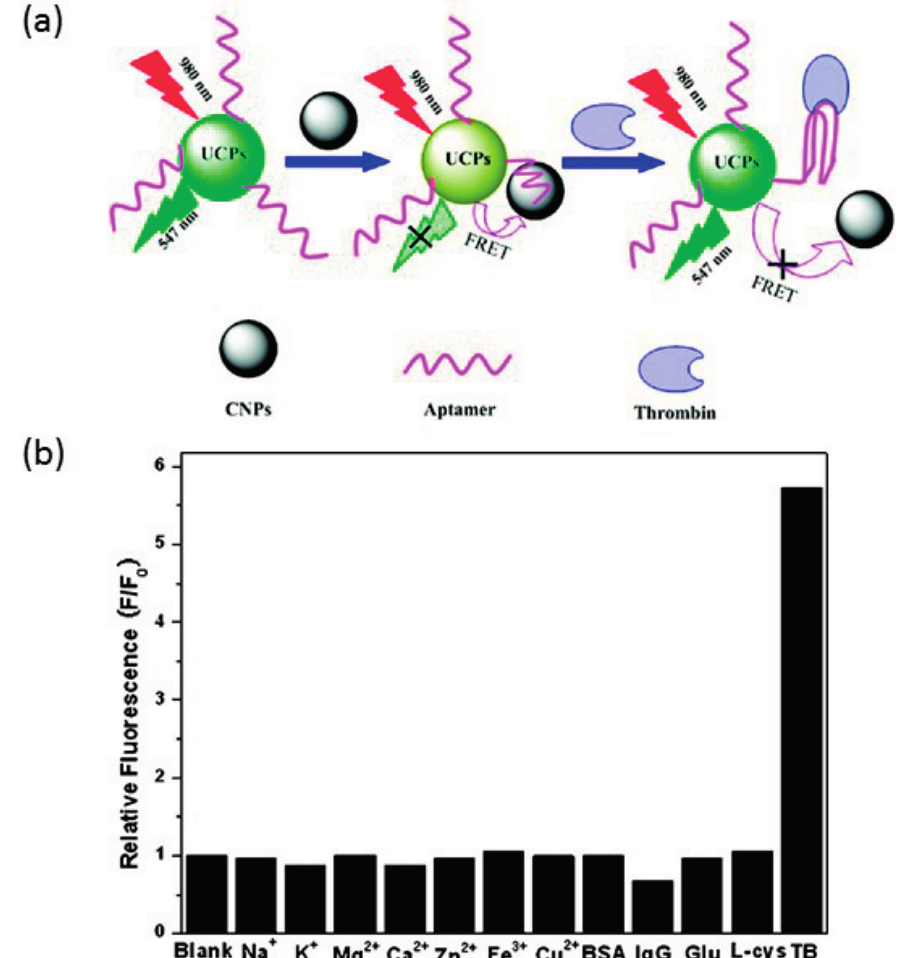
Figure 2. ( a ) Scheme showing the FRET process from upconverting phosphors (UCPs) to CNPs; ( b ) interference testing shows that the fluorescent intensity increases dramatically